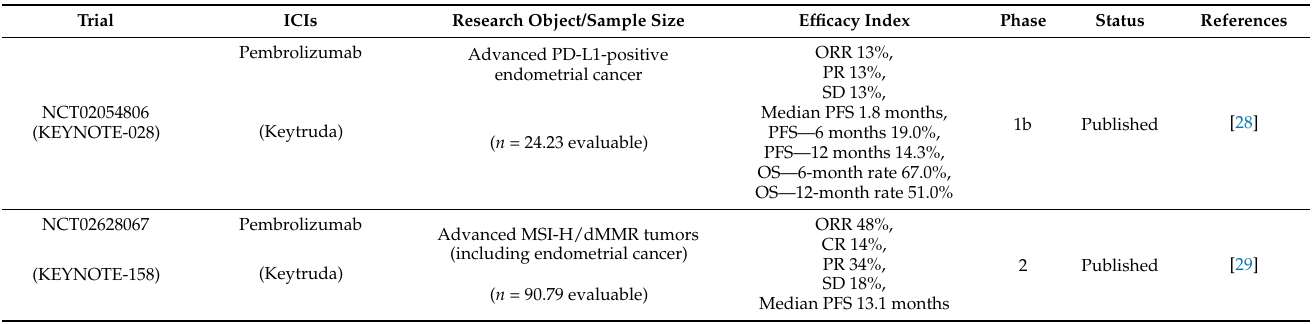
Table 1. Clinical trials of immune checkpoint inhibitors in endometrial